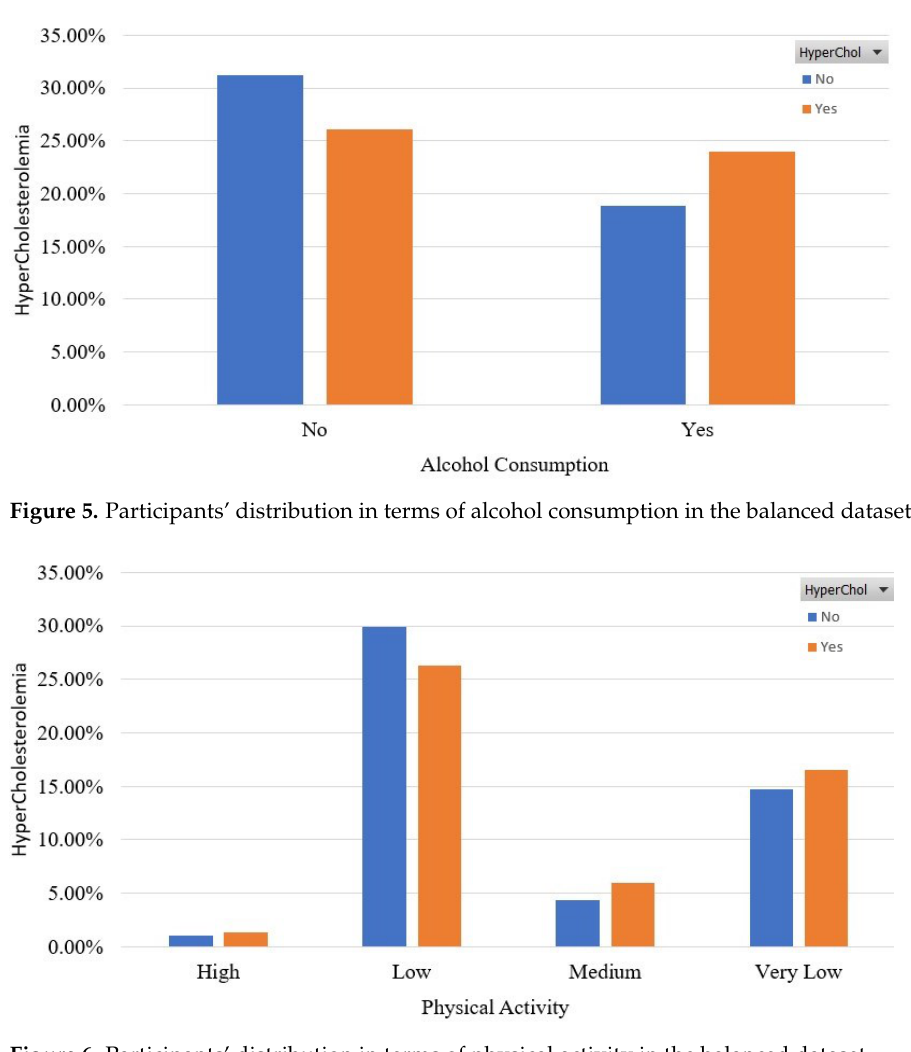
Figure 6. Participants’ distribution in terms of physical activity in the balanced